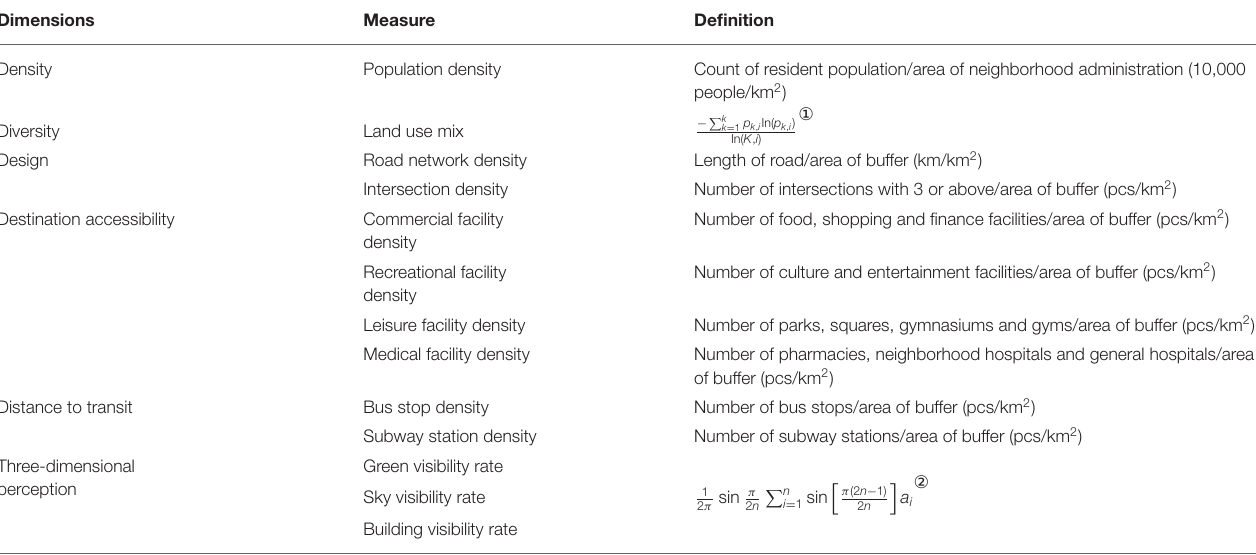
TABLE 1 | Built environment